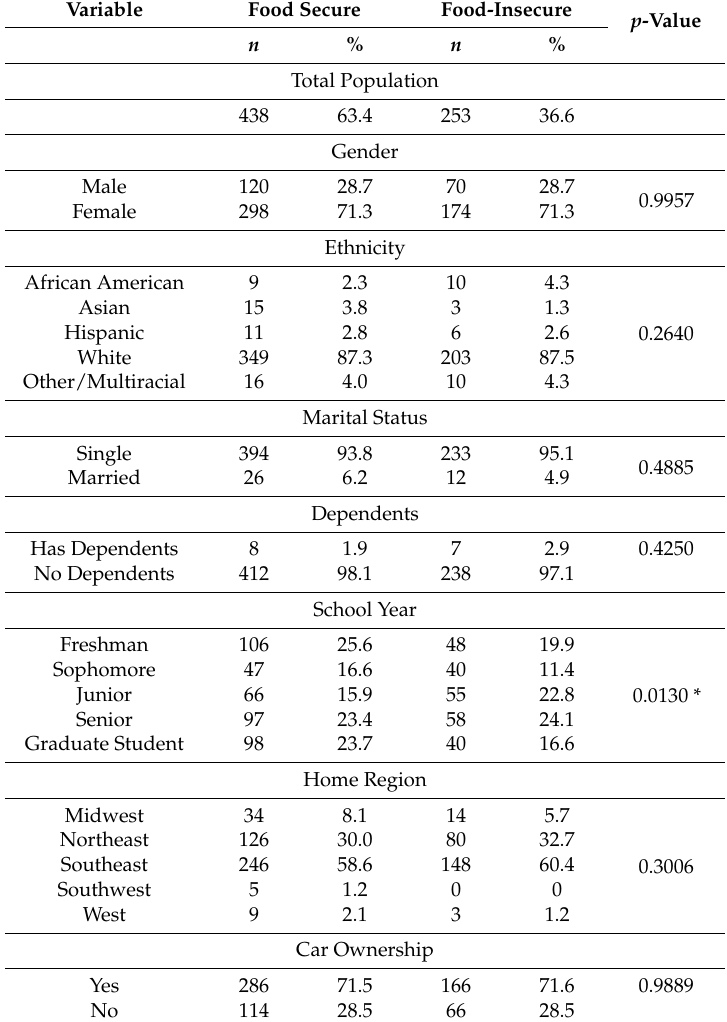
Table 1. Characteristics of respondents and correlations with food security